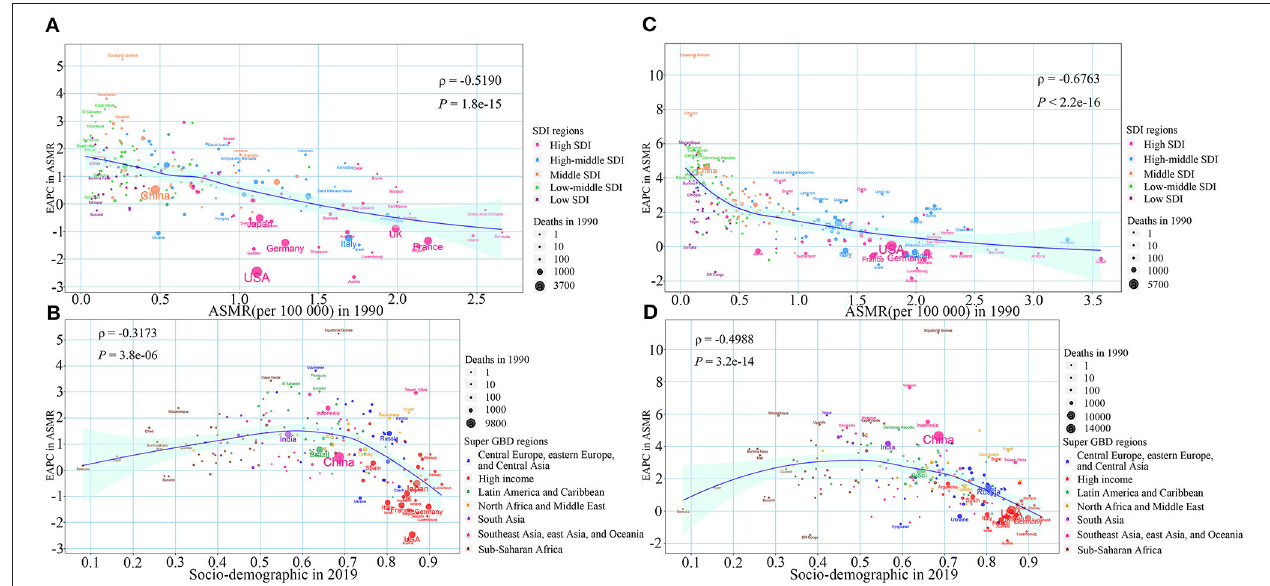
FIGURE 4 | The association between the EAPC of colorectal cancer ASMR and the corresponding ASMR in 1990 and SDI in 2019. (A) EAPC of ASMR due to low physical activity and the corresponding ASMR in 1990; (B) EAPC of ASMR due to high BMI and the corresponding ASMR in 1990; (C) EAPC of ASMR due to low physical activity and the SDI in 2019; (D) EAPC of ASMR due to high BMI and the SDI in 2019. The blue line was an adaptive association fitted with adaptive Loess regression based on all data points. EAPC, estimated annual percentage change; ASMR, age-standardized mortality rate; SDI, sociodemographic index; BMI, body mass